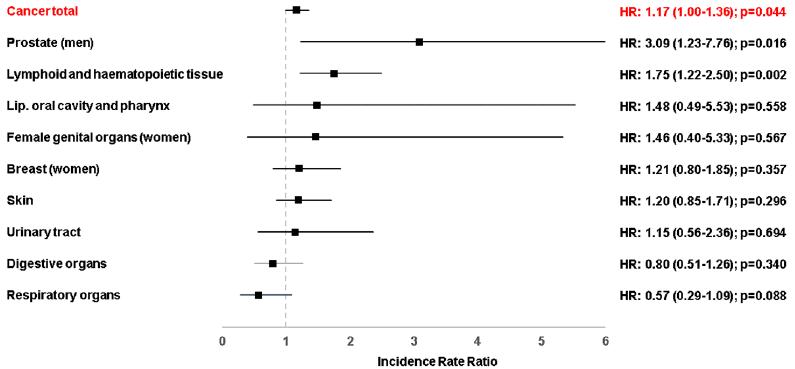
Figure 2. Association between infectious mononucleosis and different cancer diagnoses in patients followed in general practices in Germany (Multivariable Poisson regression models). Multivariable Poisson regression models adjusted for diabetes mellitus, thyroid gland disorders, obesity, diseases of esophagus, stomach and duodenum, diseases of liver, chronic bronchitis and COPD. Table 1. Association between infectious mononucleosis and the subsequent cancer diagnoses in pa- tients followed in general practices in Germany (Multivariable Poisson regression model).